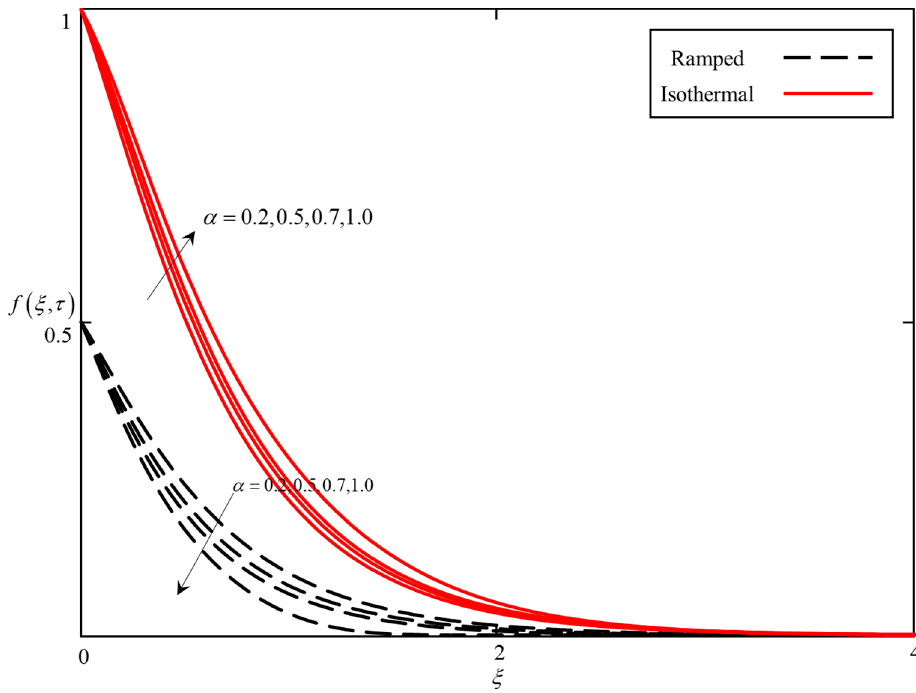
Figure 6. Consequence of α on the velocity field, when β = 0.5, φ = 0.04, λ 1 = 0.5, λ 2 = 0.5, M = 0.5, K = 0.5 Pr = 21, and Gr = 5.0.